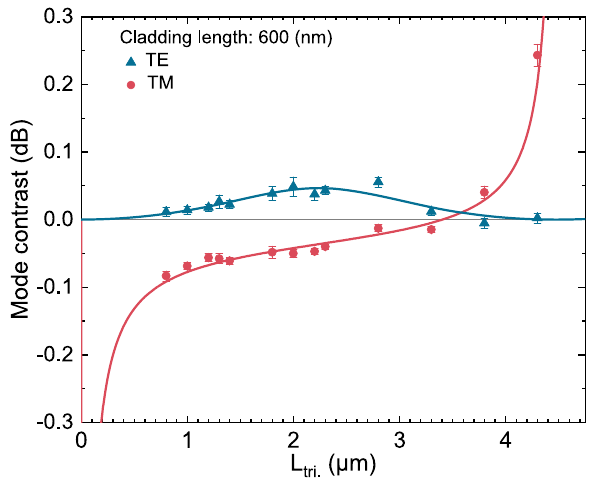
) obtained from TX tri.